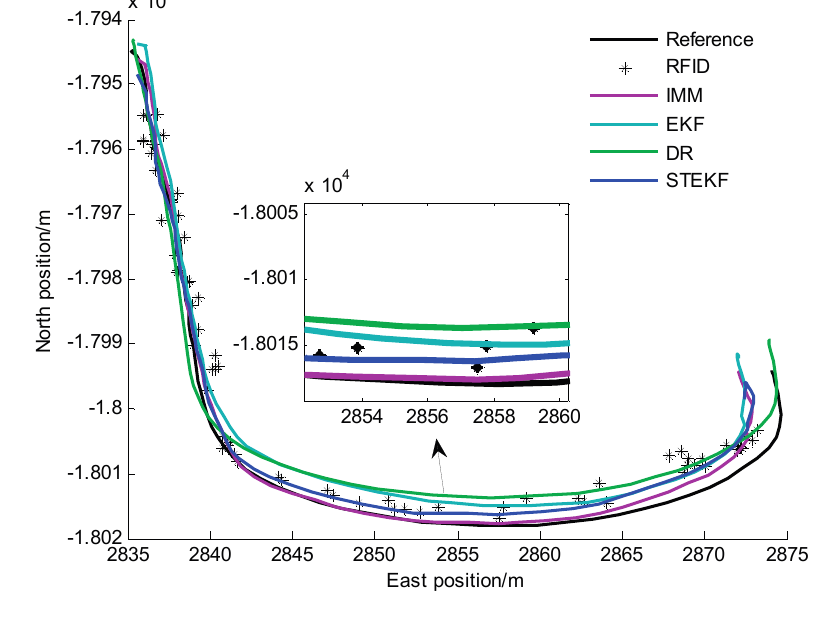
Figure 12. The reference and estimated vehicle trajectories in comprehensive test.